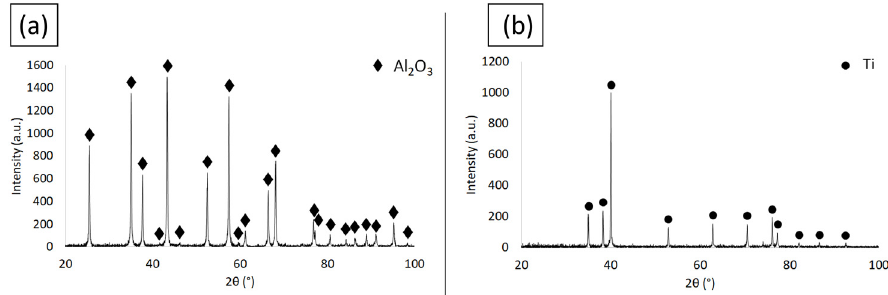
Figure 1. Diffractograms of the starting powders: ( a ) Al 2 O 3 , ( b ) Ti. Microstructural observations of the Al 2 O 3 powder were performed as well. Figure 2 shows example SEM images of alumina (a) and titanium (b) powders. Research results revealed that the alumina powder is distinguished by its tendency to form